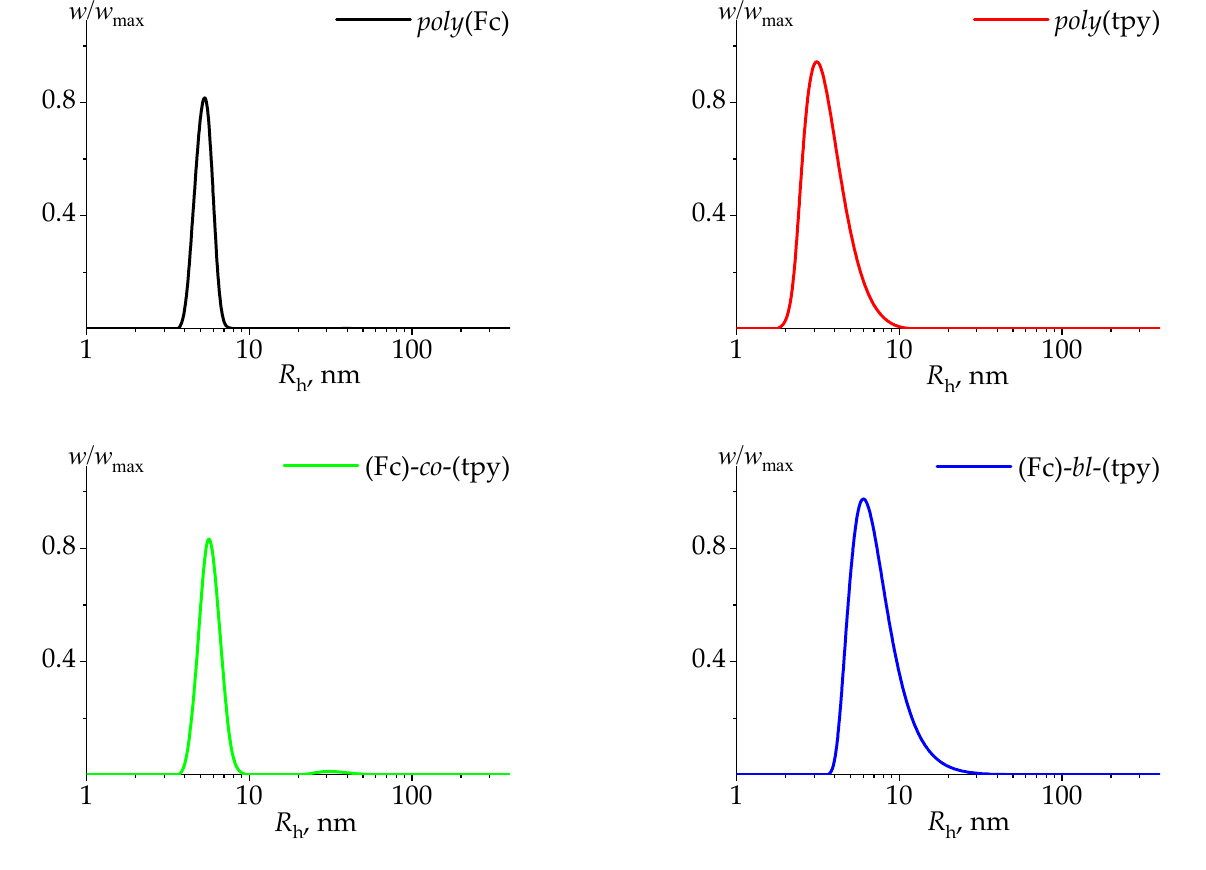
Figure 5. The normalized distributions of weight component concentration, w / w max , over hydrody- namic radii, R h , obtained with DLS for the studied polymers ( poly (Fc), poly (tpy)) and copolymers ((Fc)- co -(tpy), (Fc)- bl -(tpy)) in THF solutions. All data were obtained at 20 ◦ C. The diffusion coeffi- cients, D 0 , at the infinite dilution limit are presented in Table 3. Table 3. The hydrodynamic parameters, hydrodynamic invariants, and molar masses of the studied Fc-/tpy-containing (co)polymers defined in the specified solvents at 20 ◦